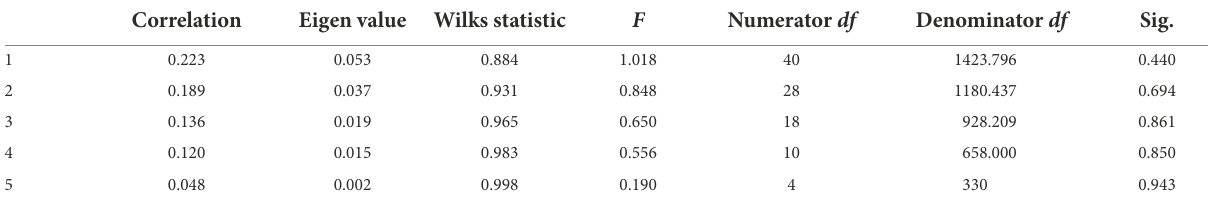
TABLE 4 Canonical correlations among five personality measures and eight dimensions formed by linguistic features. Correlation